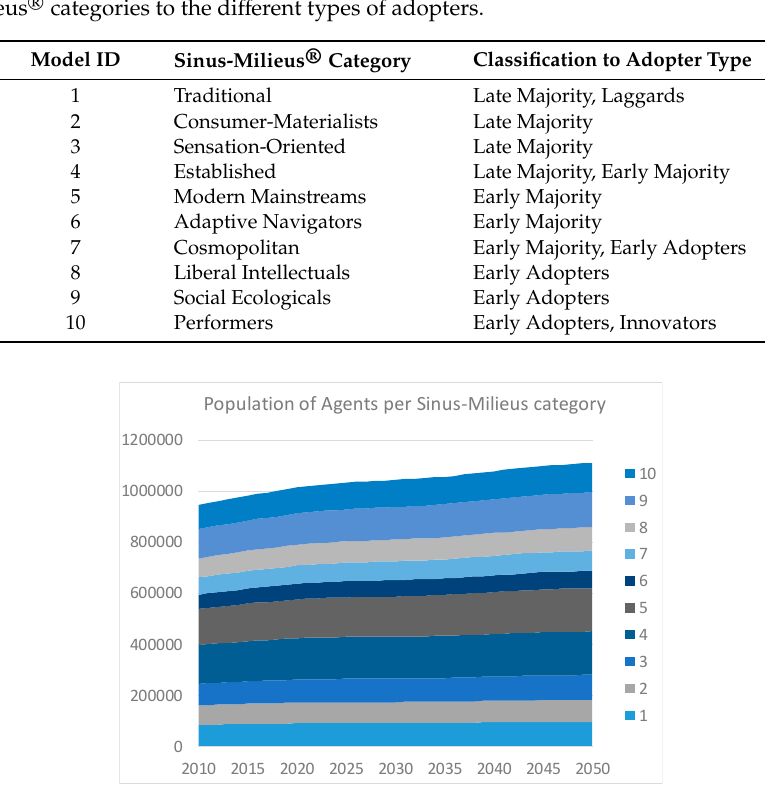
Figure 4. Assumed evolution of the agents in the model, per Swiss Canton.